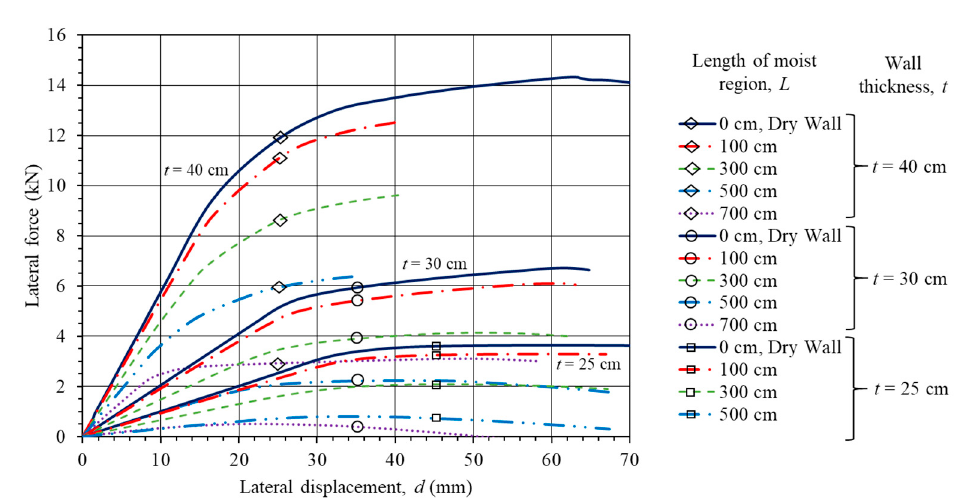
Figure 5. Pushover curves for Scenario w ps .